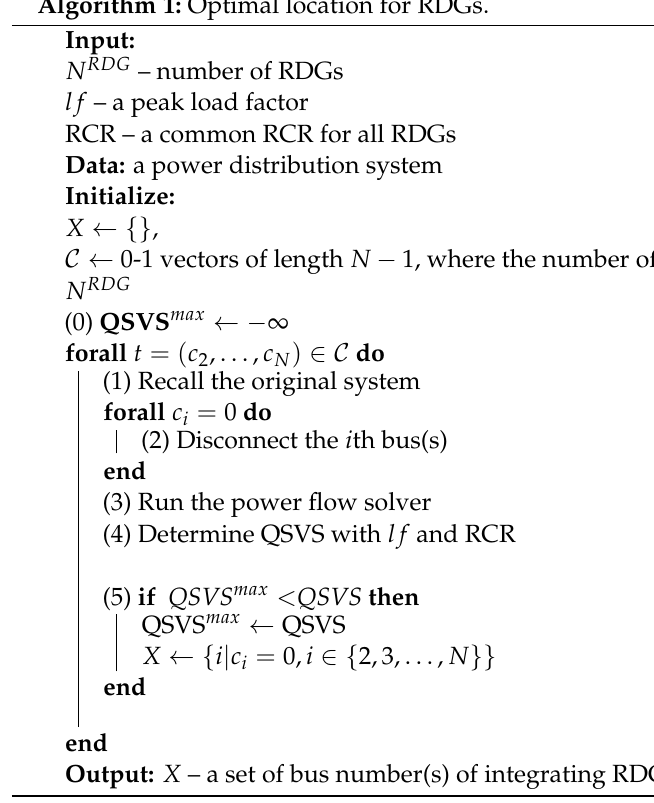
Algorithm 1: Optimal location for